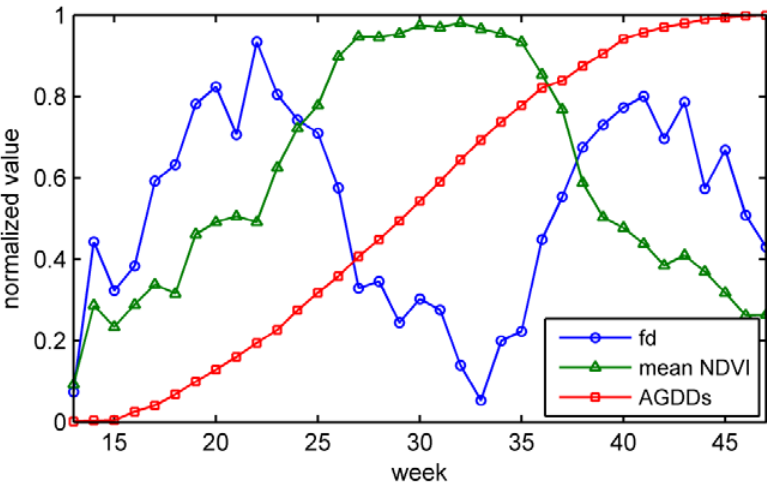
Figure 2. Distributions of normalized mean Normalized Difference Vegetation Index (NDVI), fractal dimension (fd), and AGDDs along the corn life cycle (Iowa,